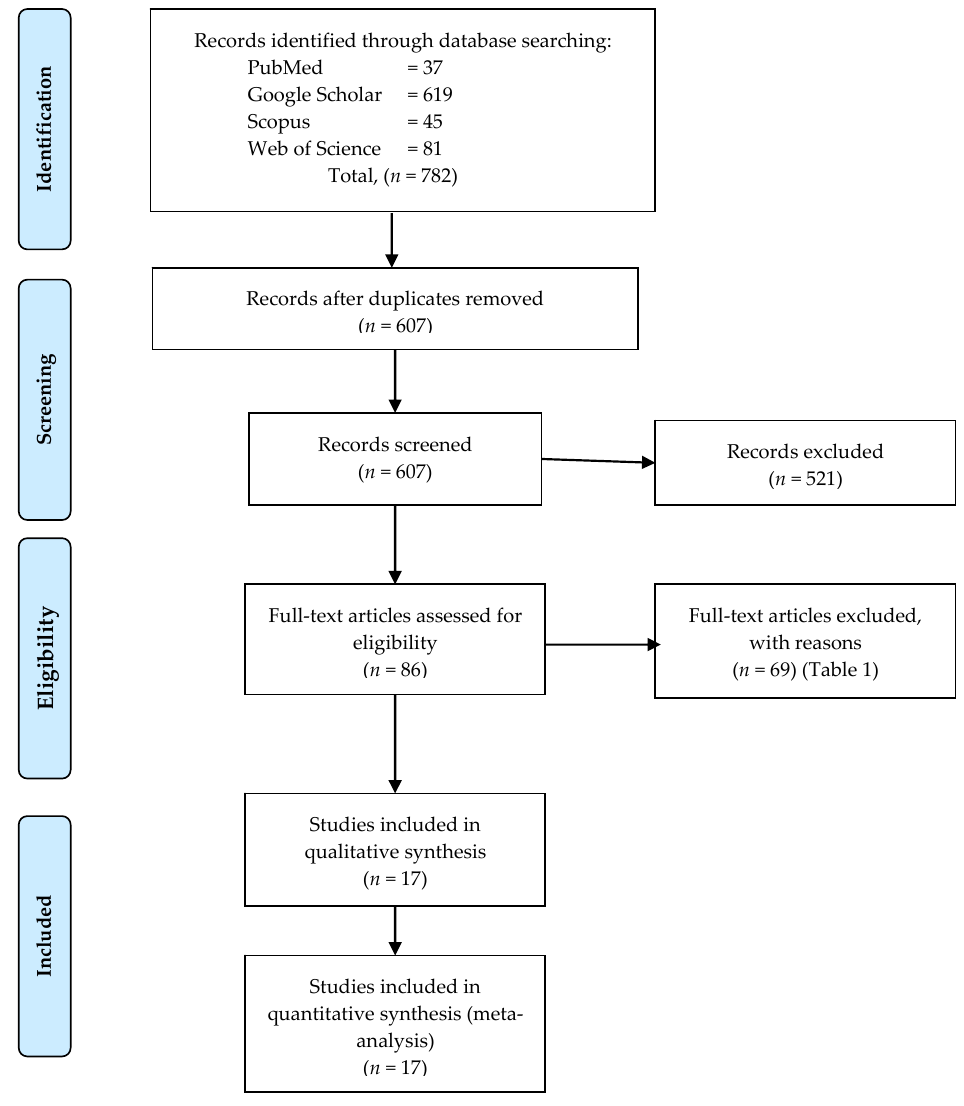
Figure 1. PRISMA flow diagram of study selection and screening [12].